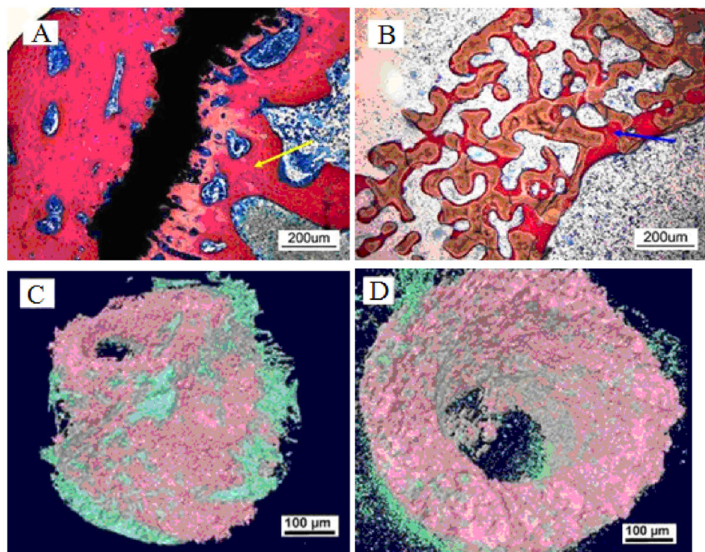
Figure 10. Histological photographs of meth- ylene blue and magenta staining of bone tissue formed around the MAO-coated magnesium implant ( A ) and the uncoated magnesium ( B ) implant 3 months after implantation in the greater trochanter where arrows indicate newly formed bone. Micro-CT 3-D reconstruction models of newly formed bone (green in color) on both coated magnesium ( C ) and uncoated magne- sium ( D ) implants 3 months post-operation are shown. MAO: micro-arc